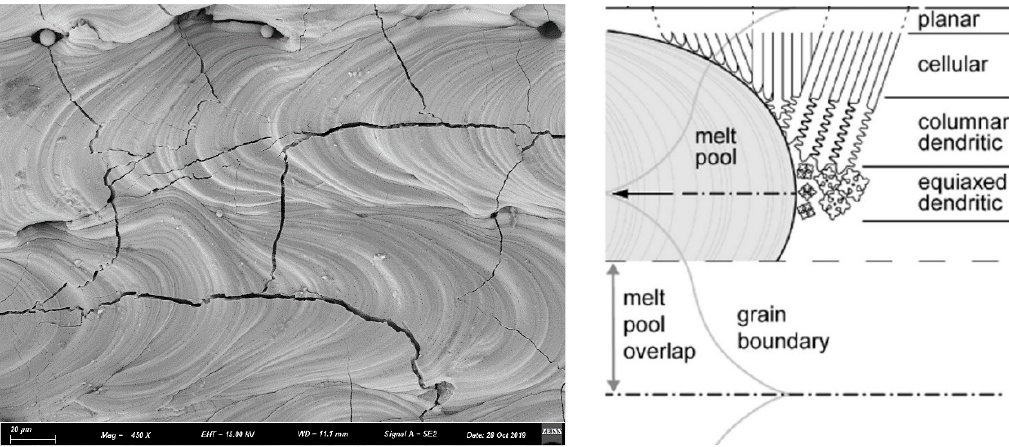
Figure 12. Schematic representation of the microstructural development during SLM.